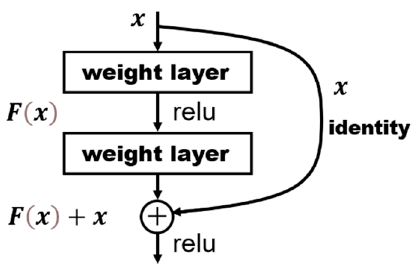
Figure 9. Basic architecture of residual block.